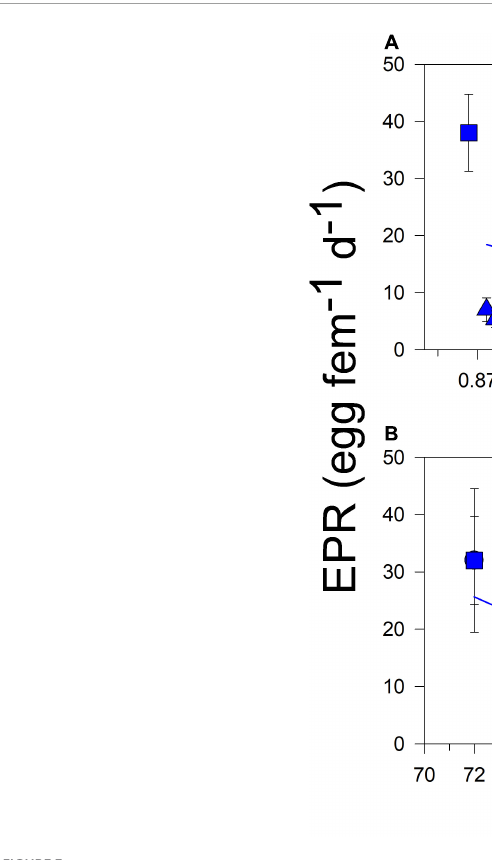
mitigating (i.e., positive) effect on the EPE of both